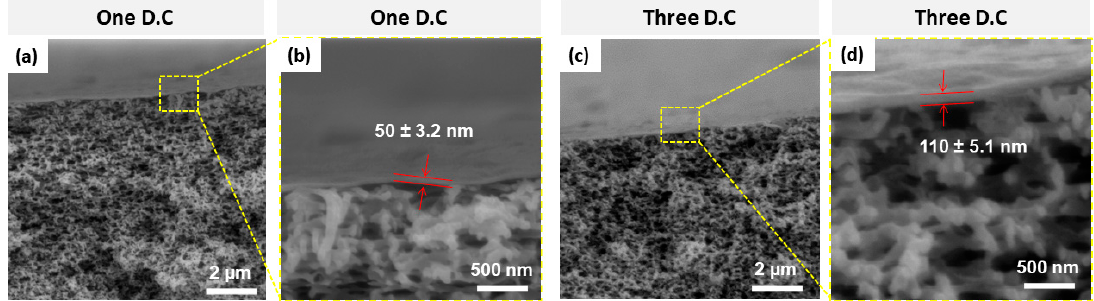
Figure 4. Cross-sectional SEM micrographs of GO-PES membranes using ( a , b ) one deposition cycle and ( c , d ) three deposition and ( c , d ) three deposition cycles.